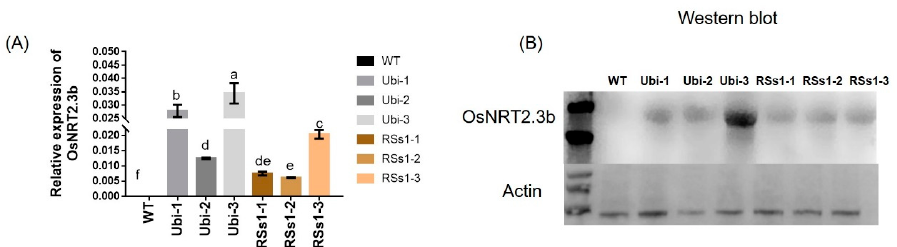
Figure 1. The OsNRT2.3b mRNA and protein expression levels in transgenic lines and WT barley plants. All plants were grown in soil in pots. ( A ) Real ‐ time quantitative PCR analysis of OsNRT2.3b mRNA. Different letters indicate a significant difference between transgenic and WT plants ( p < 0.05, one ‐ way ANOVA). Error bars: standard error ( n = 4 plants). ( B ) Western blot analysis of OsNRT2.3b expression in the barley stem. Total proteins were separated by SDS ‐ PAGE, transferred to a polyvinylidene fluoride membrane (Thermo), and hybridized with an OsNRT2.3b ‐ specific antibody. Each lane was loaded with an equal quantity of proteins (30 μ g). WT: wild ‐ type; Ubi ‐ 1/2/3 and RSs1 ‐ 1/2/3 overexpression were performed with the ubiquitin promoter and phloem ‐ specific promoter (RSs1) driven OsNRT2.3b gene, respectively, as below.